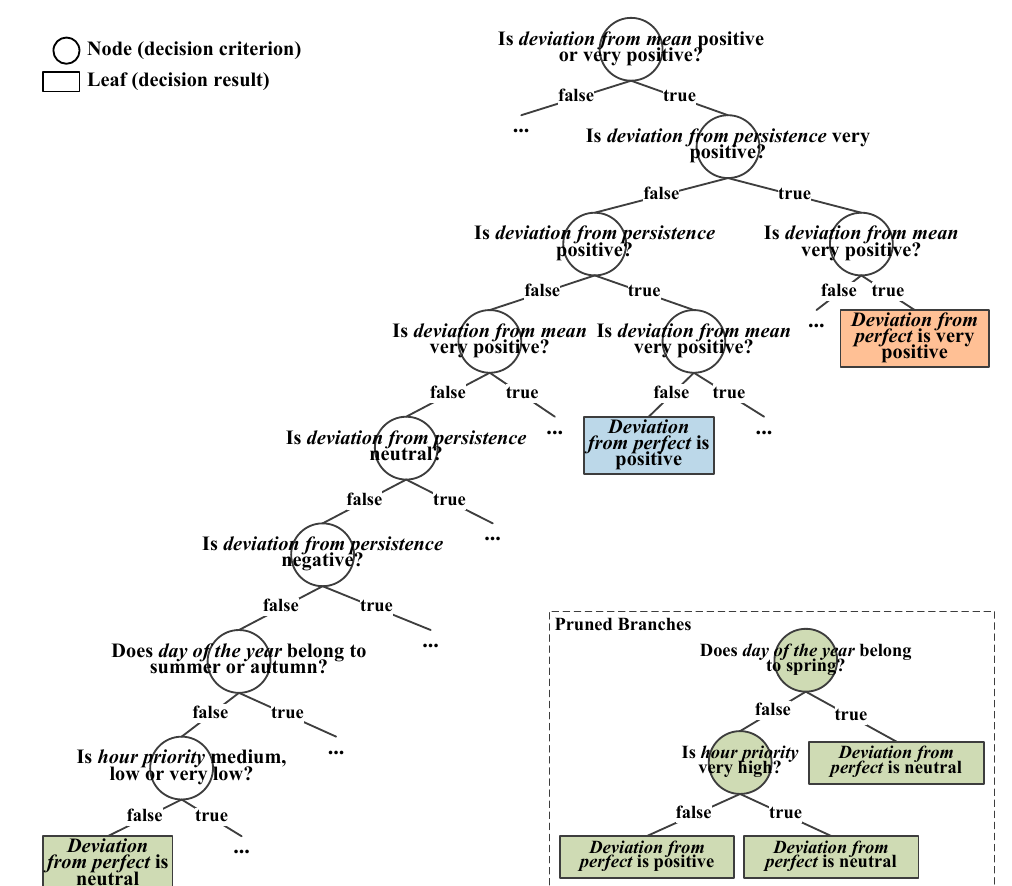
Figure 8. Some branches of an example decision tree. The leaf, in green, is the result of the pruning process and the pruned branches are outlined in detail.